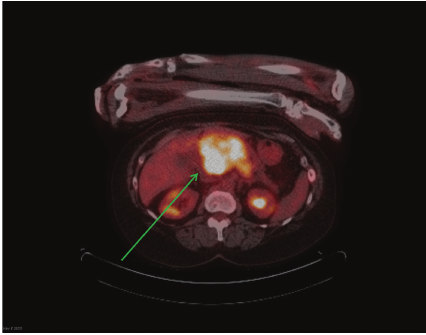
Figure 1: Axial PET/CT fusion image demonstrates a large, inten- sely FDG avid mass in the region of the pancreas (green arrow).